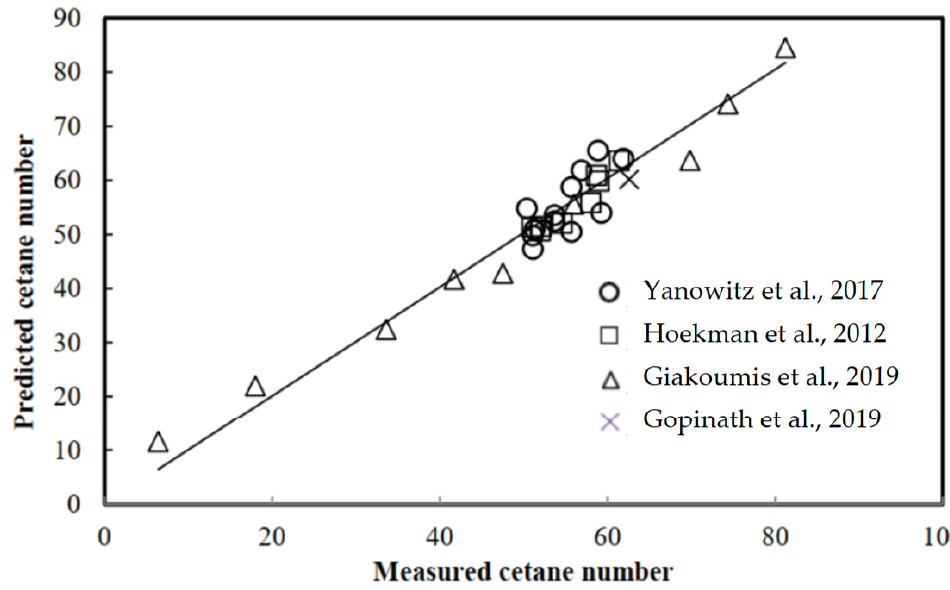
Figure 2. Derivation of the predictive formula based on the fatty acid compositions and measured data of cetane numbers by multiple linear regression analysis using SPSS software